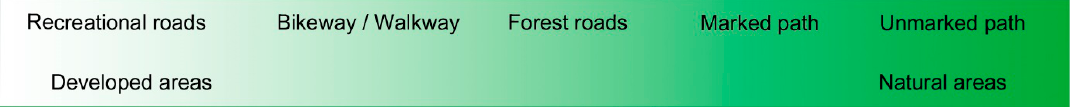
Figure 1. Five classes of recreational infrastructure continuum.